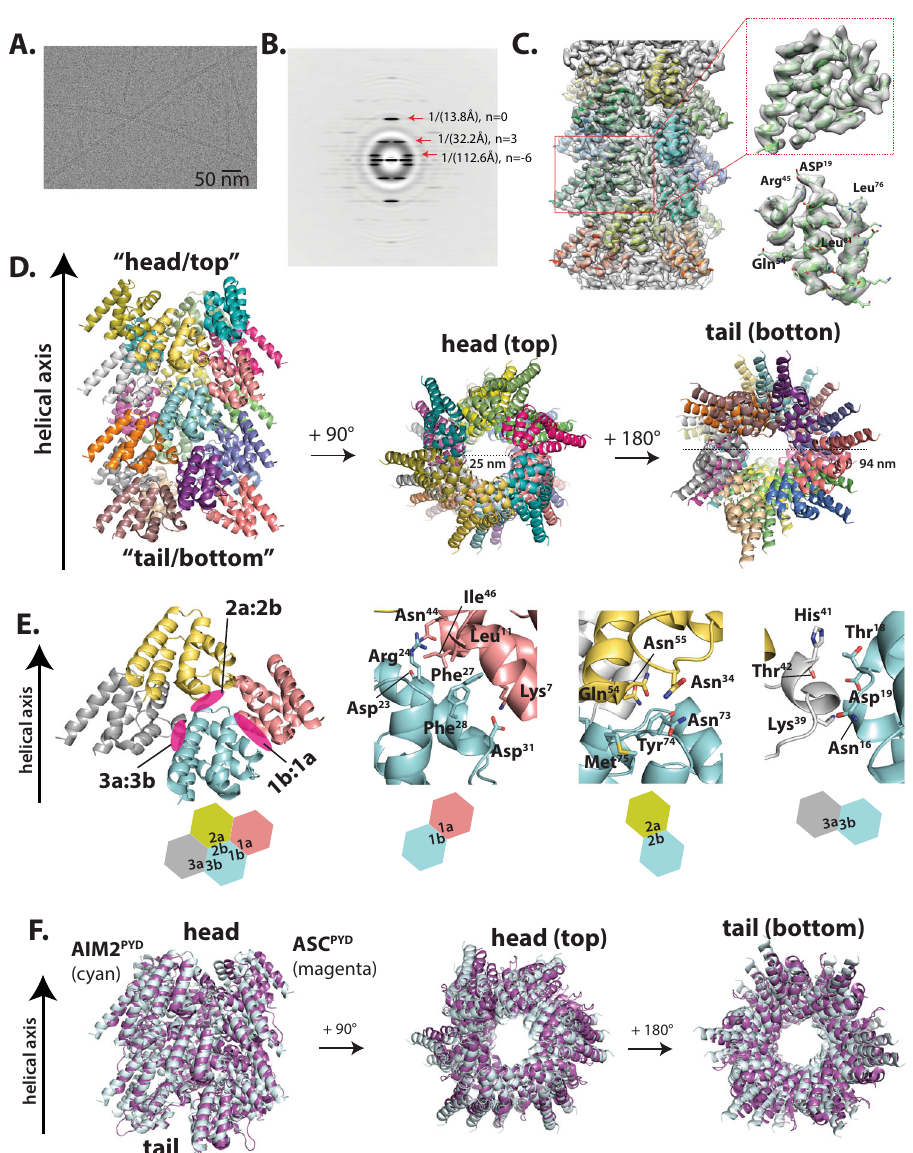
Fig. 1 AIM2 PYD assembles into an architecturally congruent fi lament as the ASC PYD fi lament. A A sample cryo-electron micrograph of the AIM2 PYD fi lament (total 976 micrographs were taken). B An average power spectrum of the AIM2 PYD fi lament from 512 px-long nonoverlapping segments. C The AIM2 PYD fi lament model built into the EM map. A subunit with visible side chains is shown. D The model of AIM2 PYD fi lament. Each subunit is colored differently. E A cartoon representation of three unique fi lament interface types. Side chains at each fi lament interface are shown as a stick con fi guration. F Overlays between AIM2 PYD and ASC PYD (PDB ID: 3J63) fi